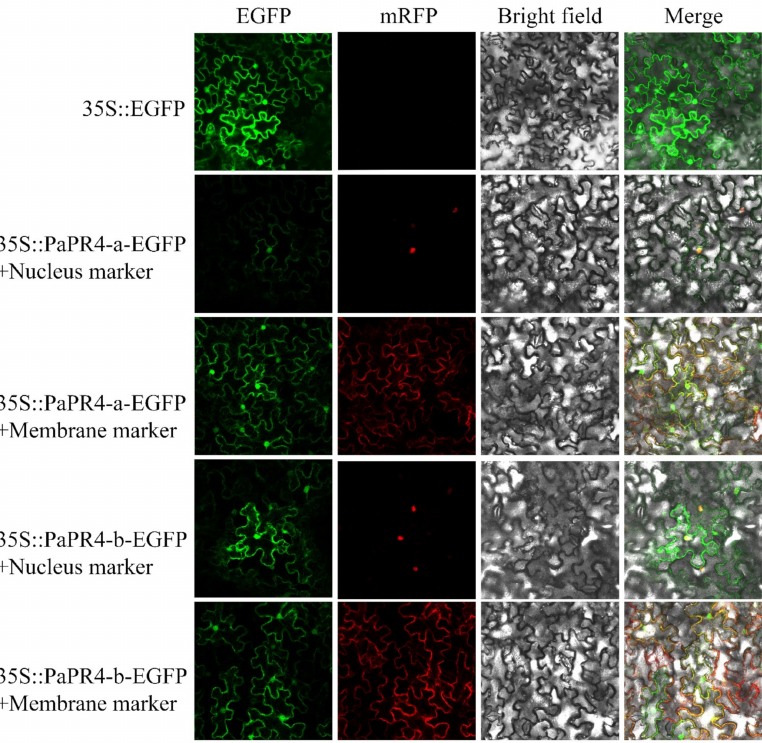
Figure 7. Subcellular localization of PaPR4-a and PaPR4-b in tobacco leaves. 35S:EGFP represents the control group.